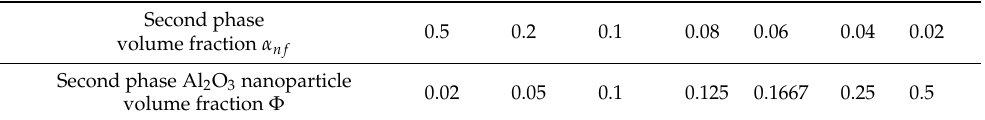
Table 2. Combinations of second phase volume fraction and of second phase nanoparticle volume fraction giving the same φ = 1% Al 2 O 3 nanofluid